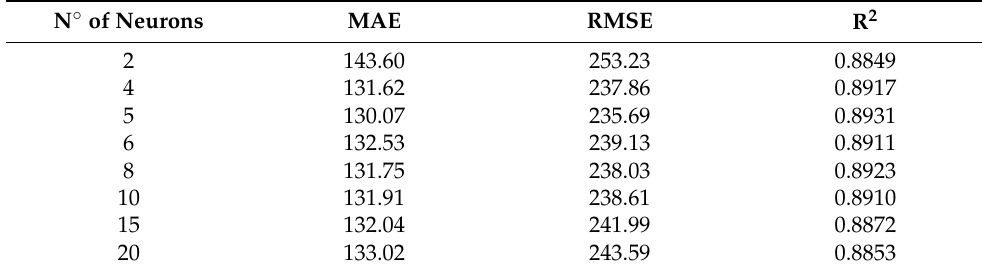
Table 2. Results of tests for hyper-parameter adjustment. N ◦ of